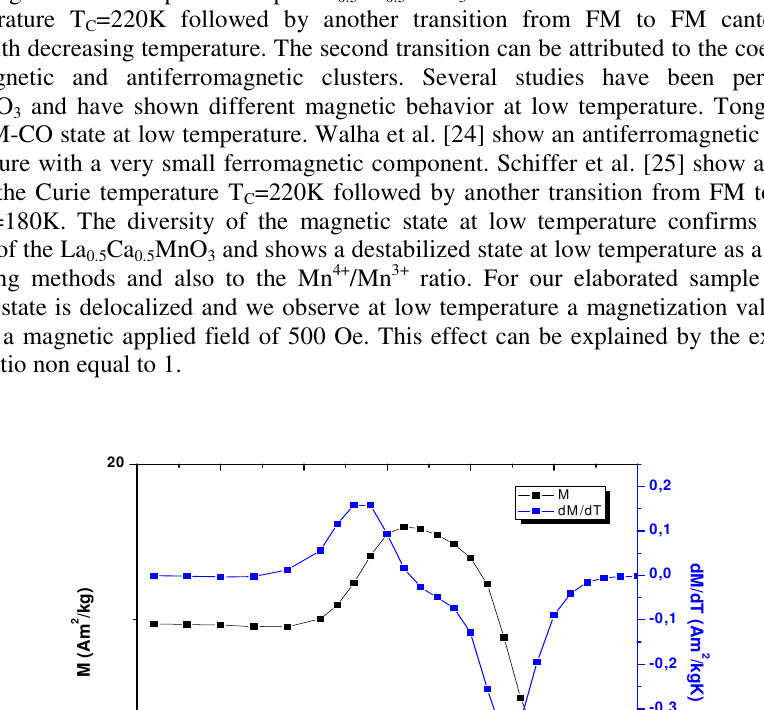
Table 2: Cell parameters, unit cell volume, <r